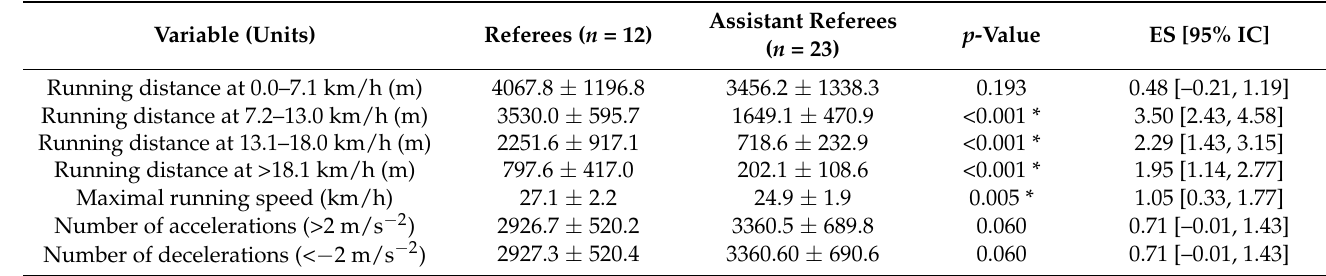
Table 1. Running parameters in referees and assistant referees while officiating an official football match.